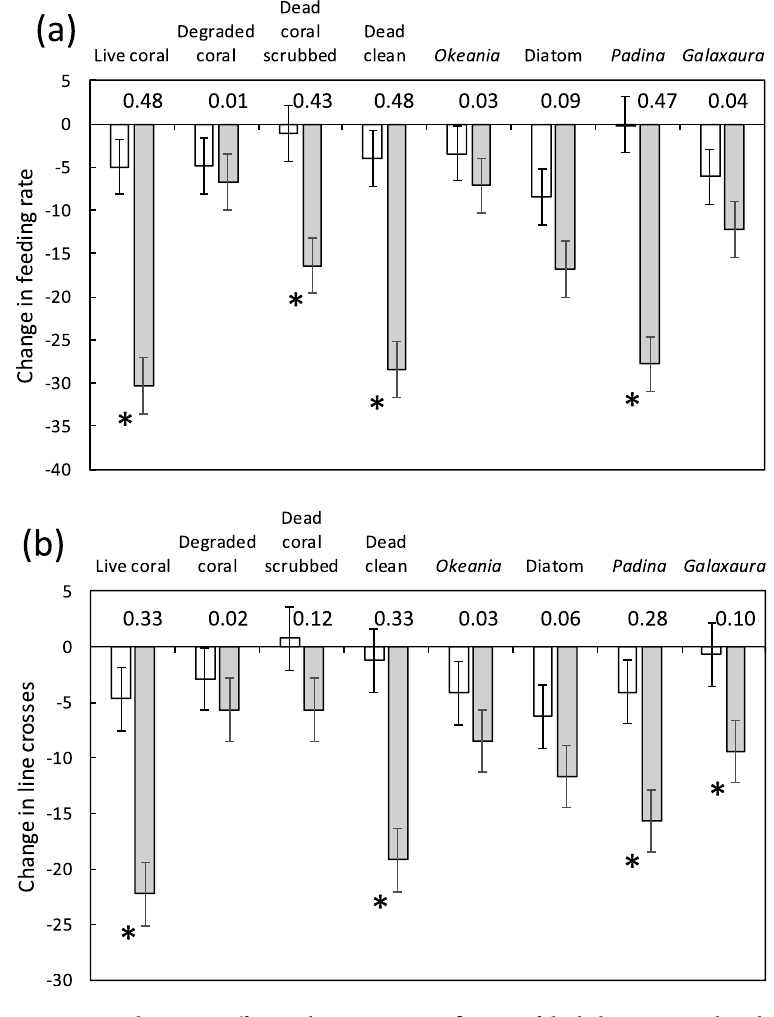
Figure 4. Habitat type affects risk assessment. Influence of the habitat type within the header tanks that supply the observation aquaria on the response of Pomacentrus amboinensis to either saltwater (white) or alarm odours (grey). ( a ) The mean number of feeding strikes ( ± SE) and ( b ) line crosses as a measure of activity are given. Asterisks represent statistically significant planned comparisons (p < 0.05), and numbers above the x-axis are the effect sizes ( η p 2 ) of the paired tests. n =